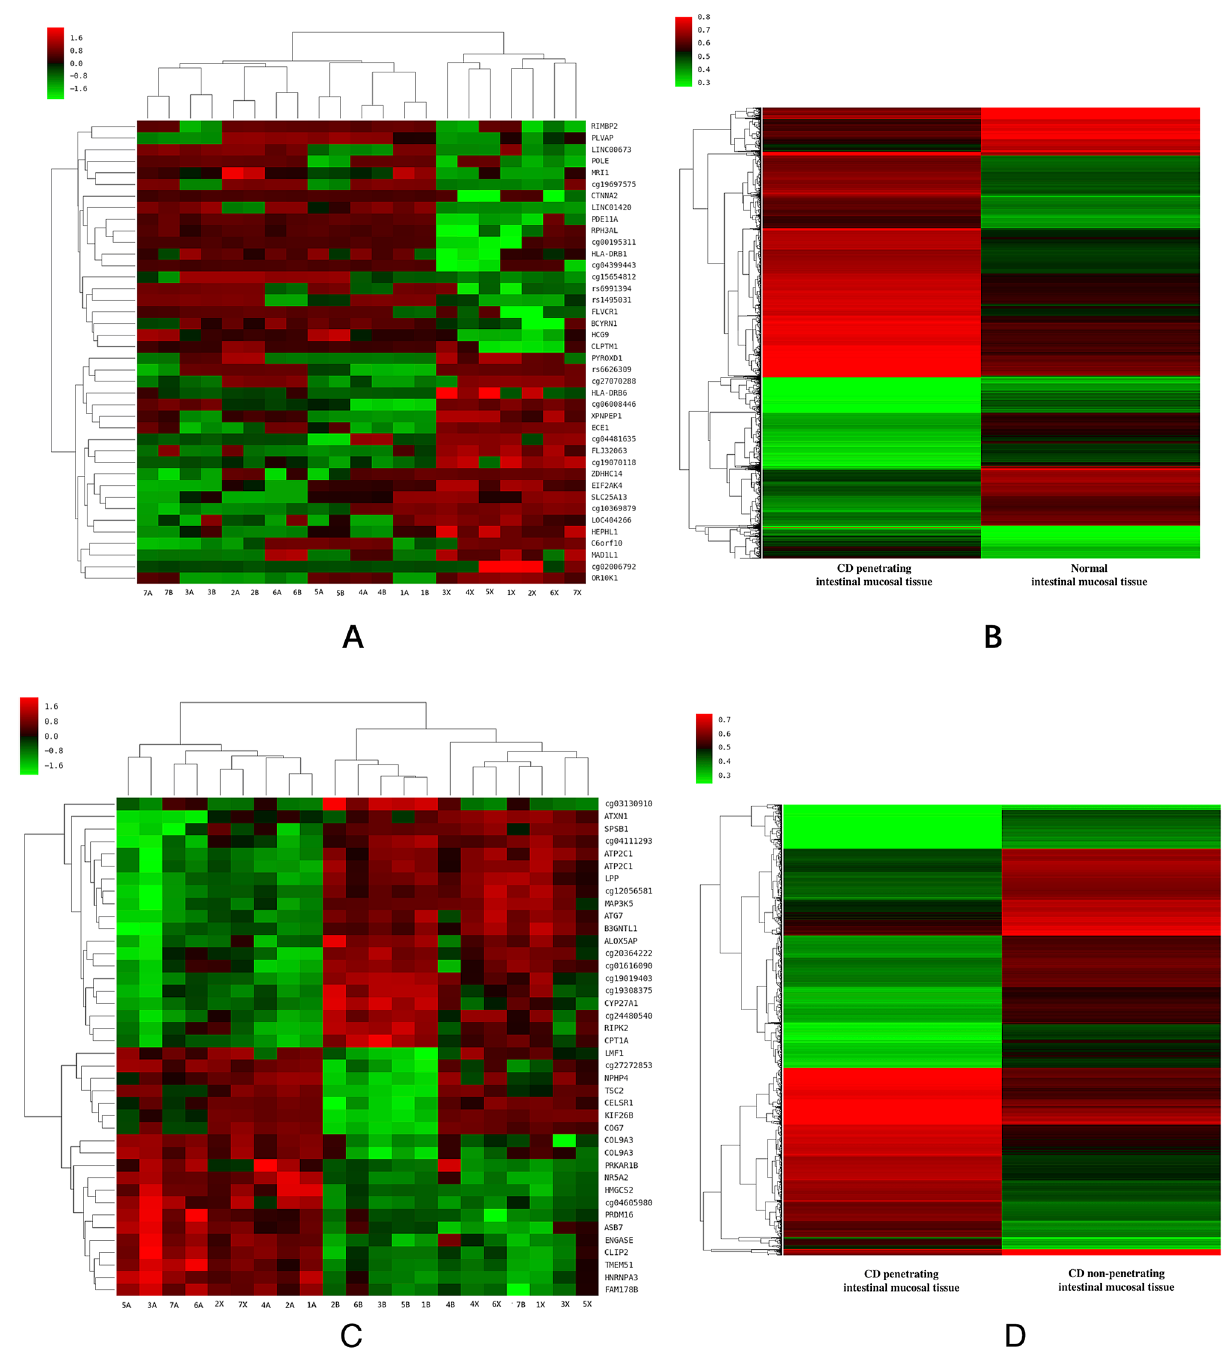
Figure 2. Cluster analysis of CD penetrating intestinal mucosal tissue and normal intestinal mucosal tissue. ( A ) The overall; ( B ) Top 20 highest degree of hypermethylation and demethylation sites; Cluster analysis of CD penetrating and non-penetrating intestinal mucosal tissue. ( C ) The overall; ( D ) Top 20 highest degree of hypermethylation and demethylation sites. The serial numbers at the bottom of ( A ) and ( C ) presented: ( A ) CD penetrating intestinal mucosal tissue; ( B ) CD non-penetrating intestinal mucosal tissue; X: normal intestinal mucosal tissue. Figures were performed with affy R package (Version 3.6.1, https:// www.r- proje ct.